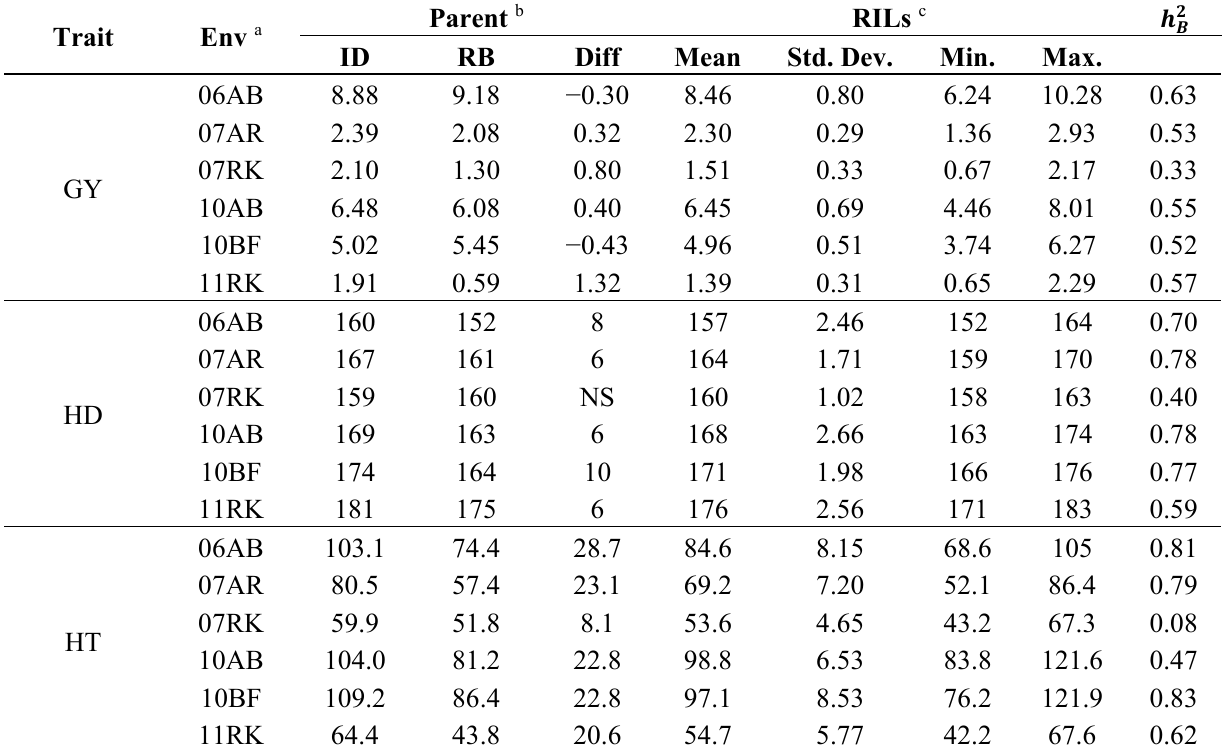
Table 1. The broad sense heritability ( (GY, ton/hectare), heading date (HD, day), and plant height (HT, cm) of the two parents and the 159 recombination inbred lines in six trials.